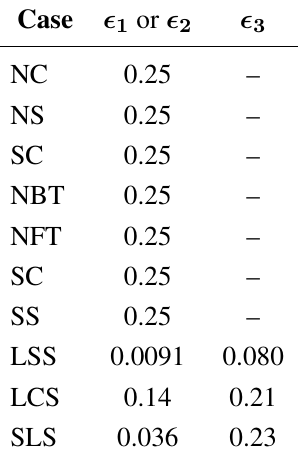
Table 5. The effective flow area. For matrix arrangements, case NC–SS, Equation (12) is used to calculate (cid:15) , and for logarithmic spiral cases, LSS–SLS, Equation (13) is used to 1 calculate (cid:15) 2